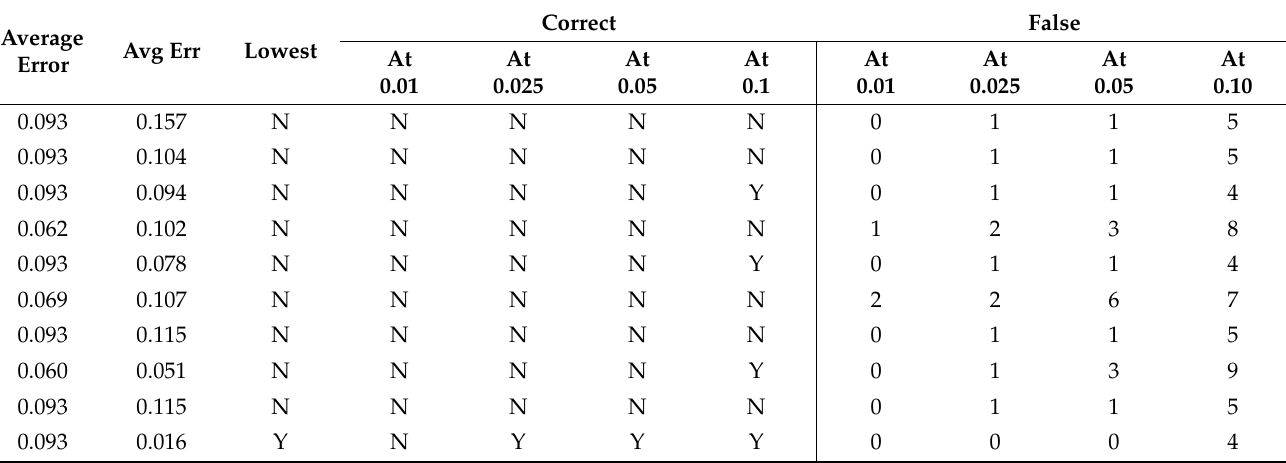
Table A199. Set 3, trials 21–30 summary data (all 0.5 PR